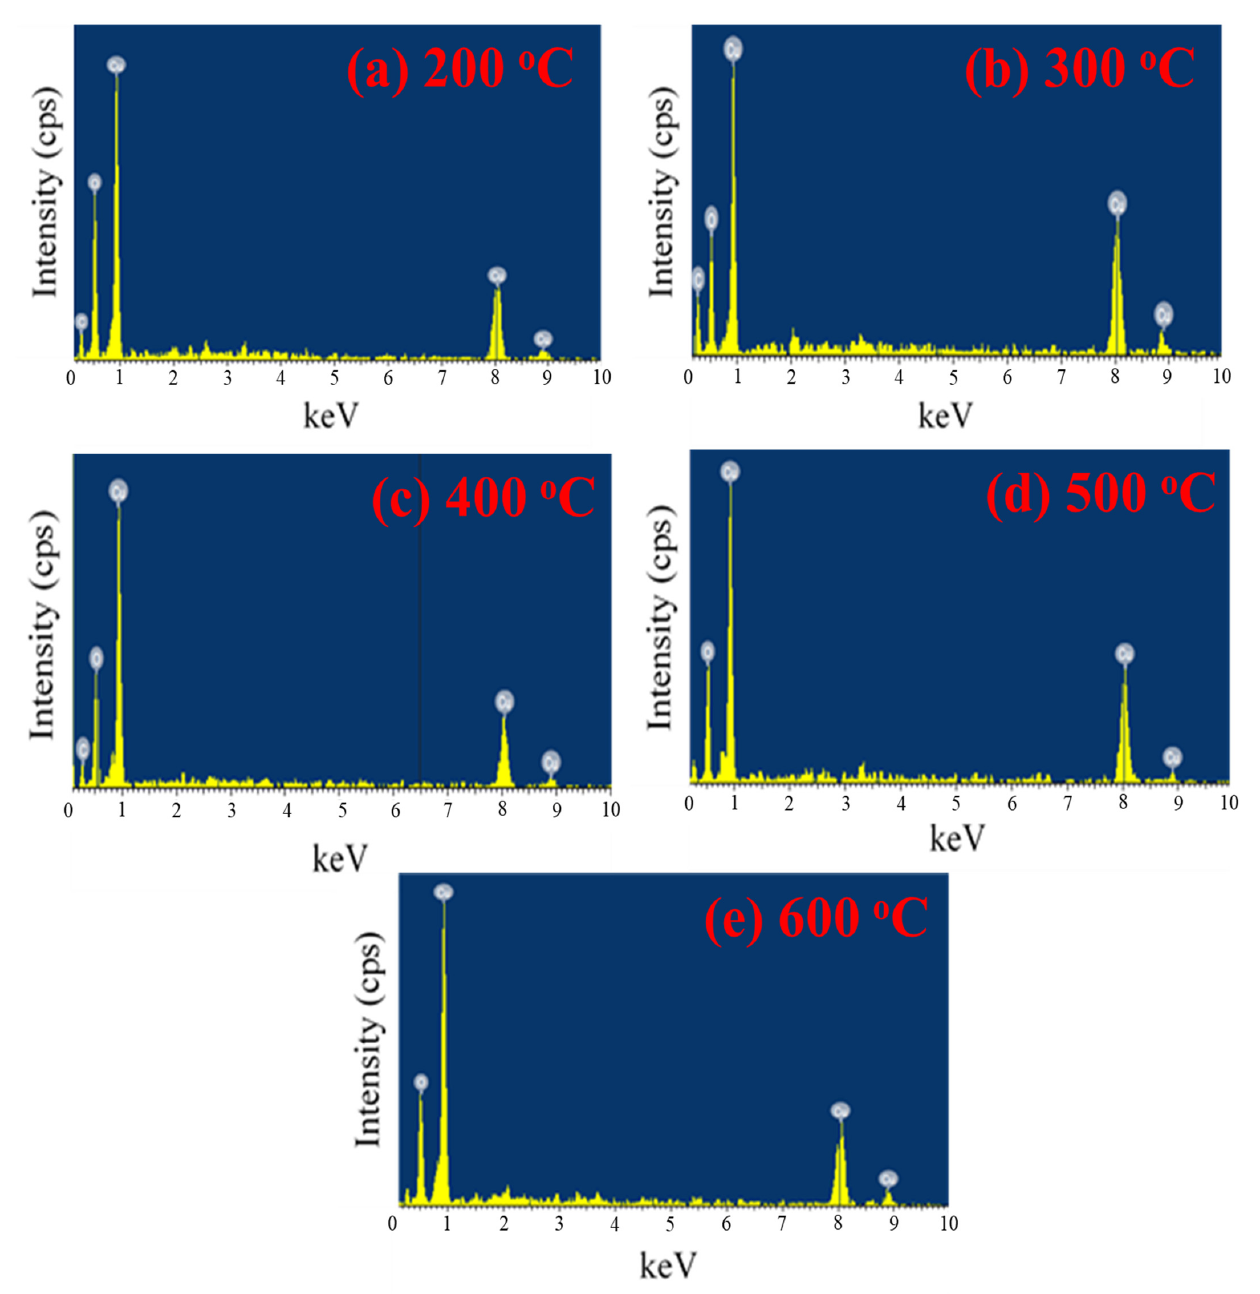
Figure 9. EDX spectrums of G. mangostana L. leaf extract-mediated synthesized CuO NPs calcinated at ( a ) 200 °C, ( b ) 300 °C, ( c ) 400 °C, ( d ) 500 °C and ( e ) 600